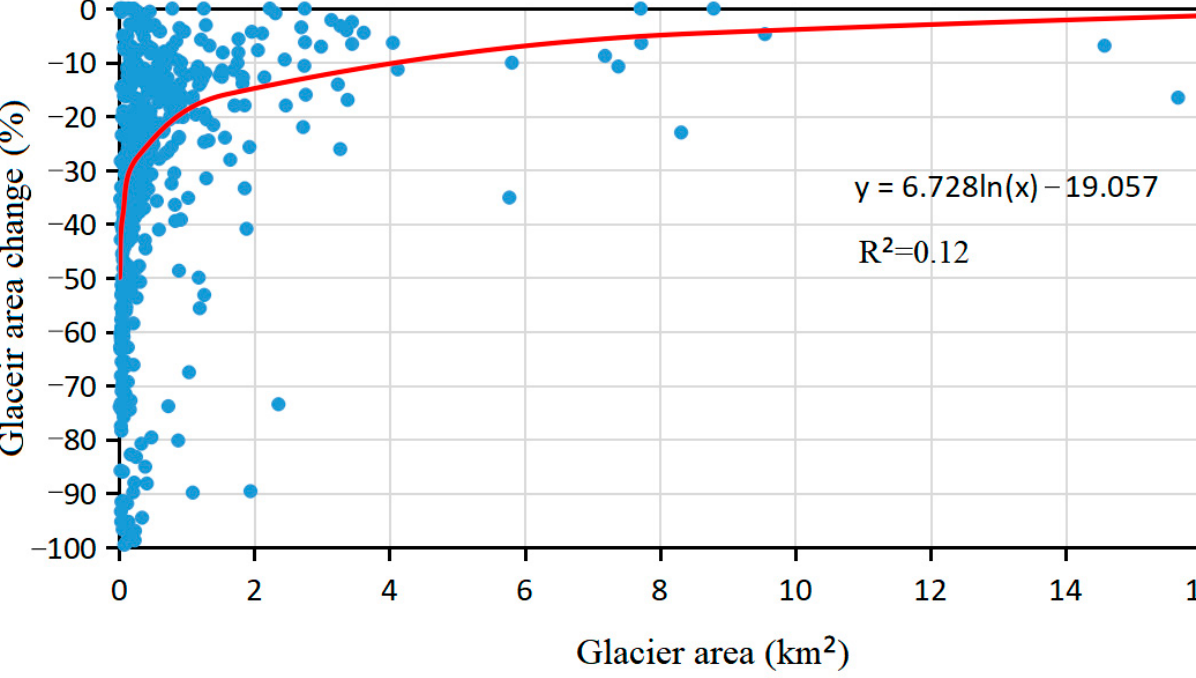
Figure 6. Changes of glaciers with different scales in the northern Tien Shan during the period 1990–